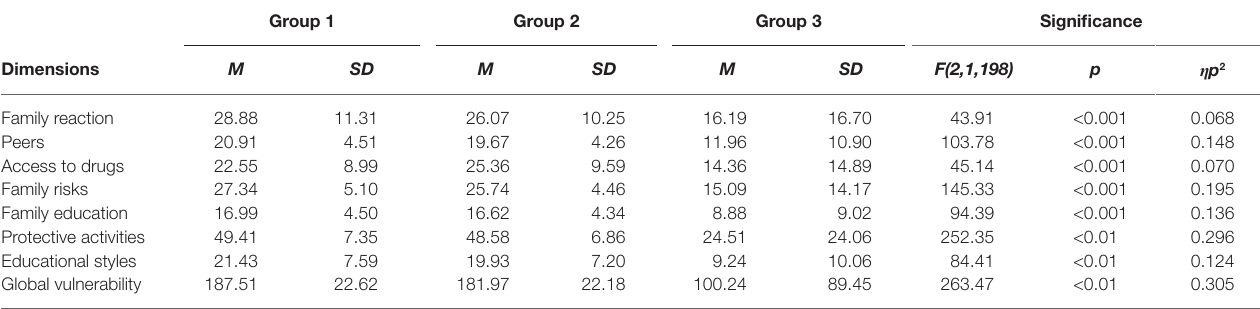
TABLE 5 | Means and standard deviations obtained by the three groups of adaptation and values of the partial eta-squared ( η p 2 ) for each dimension of interpersonal risk factors. Group 1 Group 2 Group 3